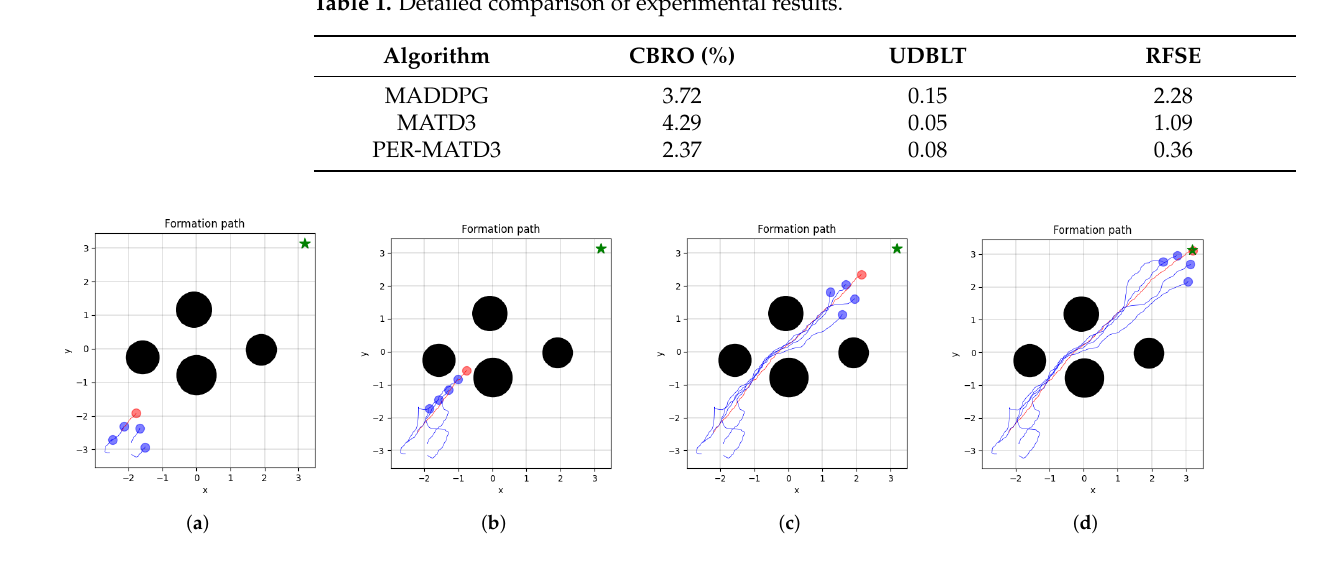
Figure 10. Multi-robot formation paths with different time steps: ( a ) Step 10; ( b ) Step 35; ( c ) Step 95; ( d ) Step